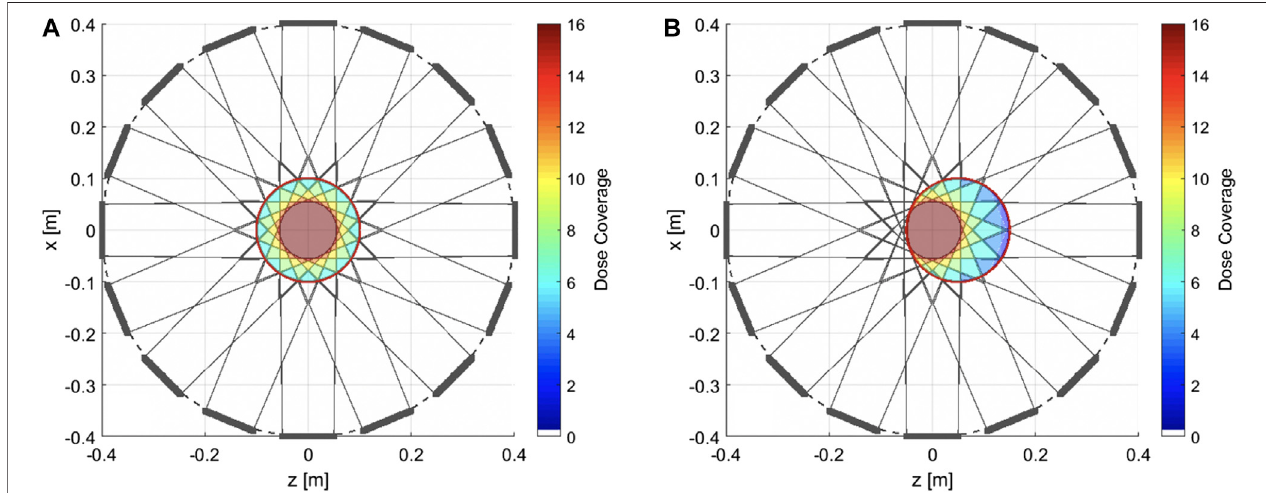
FIGURE2| Beamcoveragemap.Beamexitwindowsarerepresentedbythegraythicklines,ina Gatoroid con fi gurationwith16coilsandan80 cmdiameterbore. Foreachbeamwindow,thebeamcoverageareaisdrawn(lightgraylines). (A) Acylindricaltargetvolumeof20 cmdiameterishighlightedattheisocenter.Thecolormap indicates the number of beam windows from which the target volume can be accessed. (B) For non-isocentric targets, the same volume can be reached, with the limitation of fewer beam windows